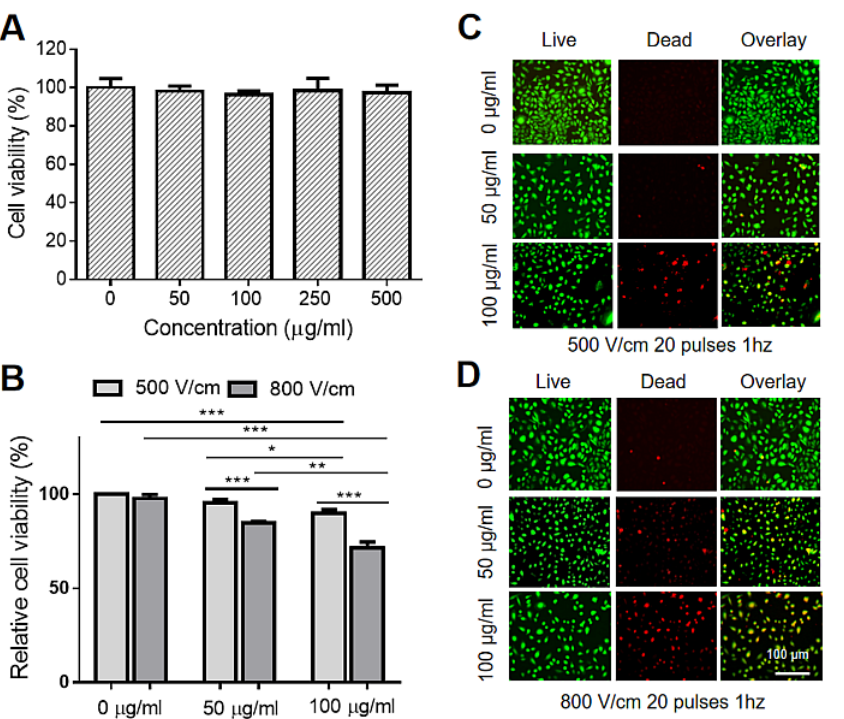
Figure 5. Enhanced cytotoxic effect of IRE on EMT-6 cancer cells under combination treatment with Au-MSNs. ( A ) Innate cytotoxicity of Au-MSNs on EMT-6 cancer cells. ( B ) Relative cell viability of EMT-6 cells after IRE treatment with Au-MSNs. Combined treatment of EMT-6 cells with IRE (800 V/cm) and Au-MSNs (100 µ g/mL) showed around 27% of enhanced cytotoxic effect when compared with single IRE (800 V/cm) treatment. ( C , D ) Live and dead staining of EMT-6 cells under IRE at 500 V/cm ( C ) and 800 V/cm ( D ) after treating with Au-MSNs. Staining was performed using Calcein-AM (green for live cells) and EthD-1 (red for dead cells) after combined treatment of Au-MSNs and IRE on EMT-6 cells. Data are provided as means ± standard deviation. Data were tested for significance using two-way ANOVA. Significant differences are indicated by * p < 0.1, ** p < 0.05, *** p < 0.01 ( n = 3–5).